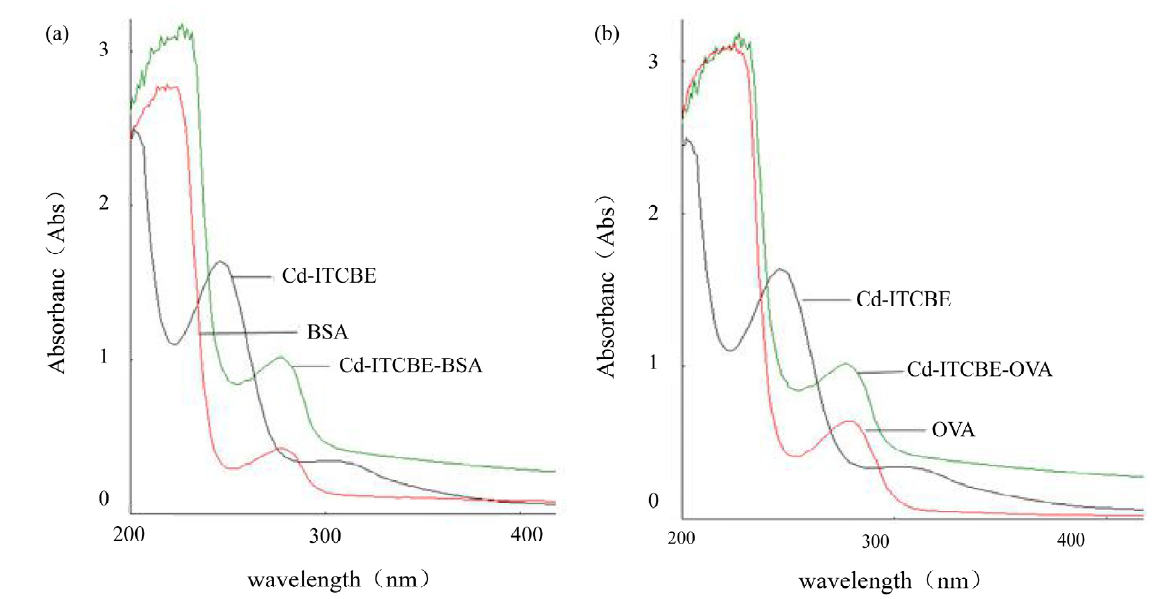
Figure 2. UV identification of Cd-1-(4-isothiocyanatobenzyl) vinyldiamine-N,N,N’,N’-tetraacetic acid (ITCBE)-bovine serum albumin (BSA) ( a ) and Cd-1-(4-isothiocyanatobenzyl) vinyldiamine-N,N,N’,N’-tetraacetic acid (ITCBE)-ovalbumin (OVA) ( b ) in the protein mixture.